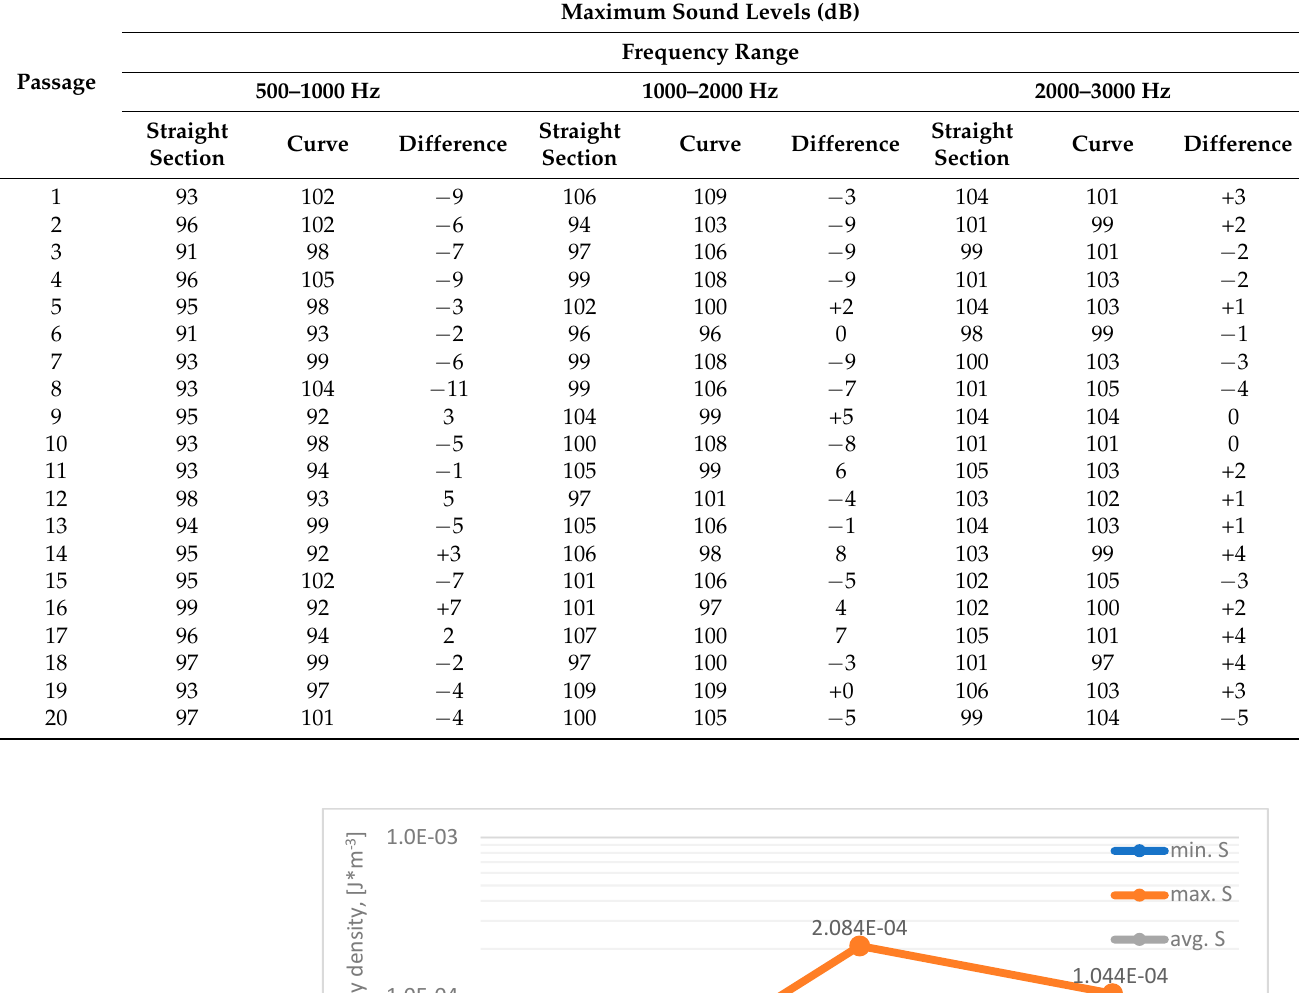
Table 4. Comparison of the maximum sound levels in separate frequency ranges for the passage of high-speed railway vehicles on a straight section and on a curve (dB).